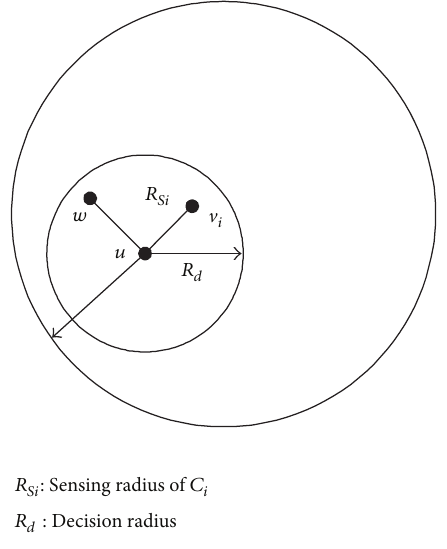
Figure 1: Decision making range